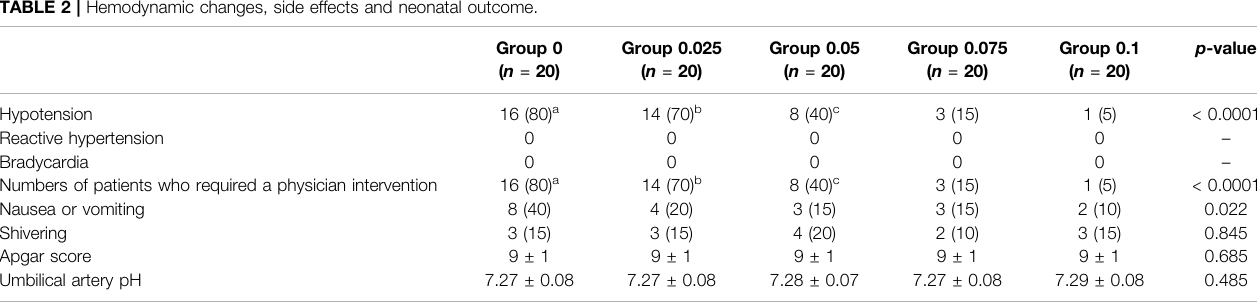
TABLE 2 | Hemodynamic changes, side effects and neonatal